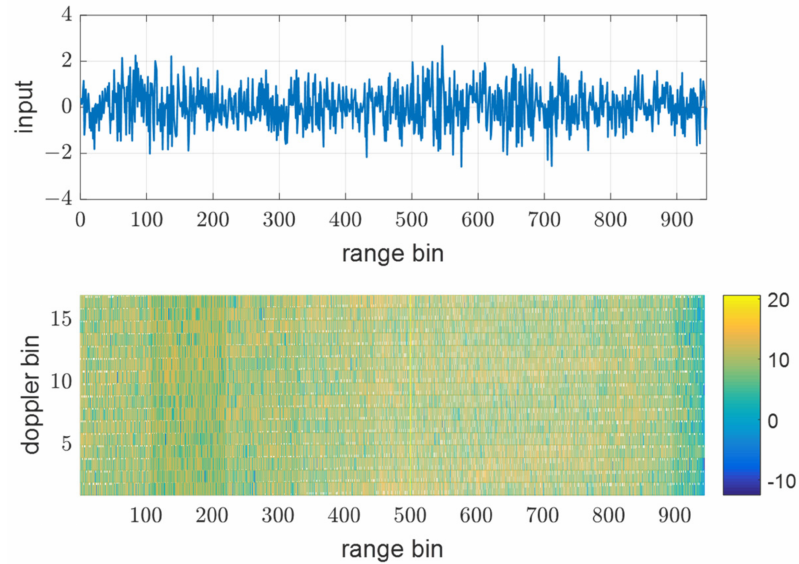
Figure 10. Input data of 10th pulse and matched filter out, y 1,3 using the different PRFs at SNR i = 0 dB.